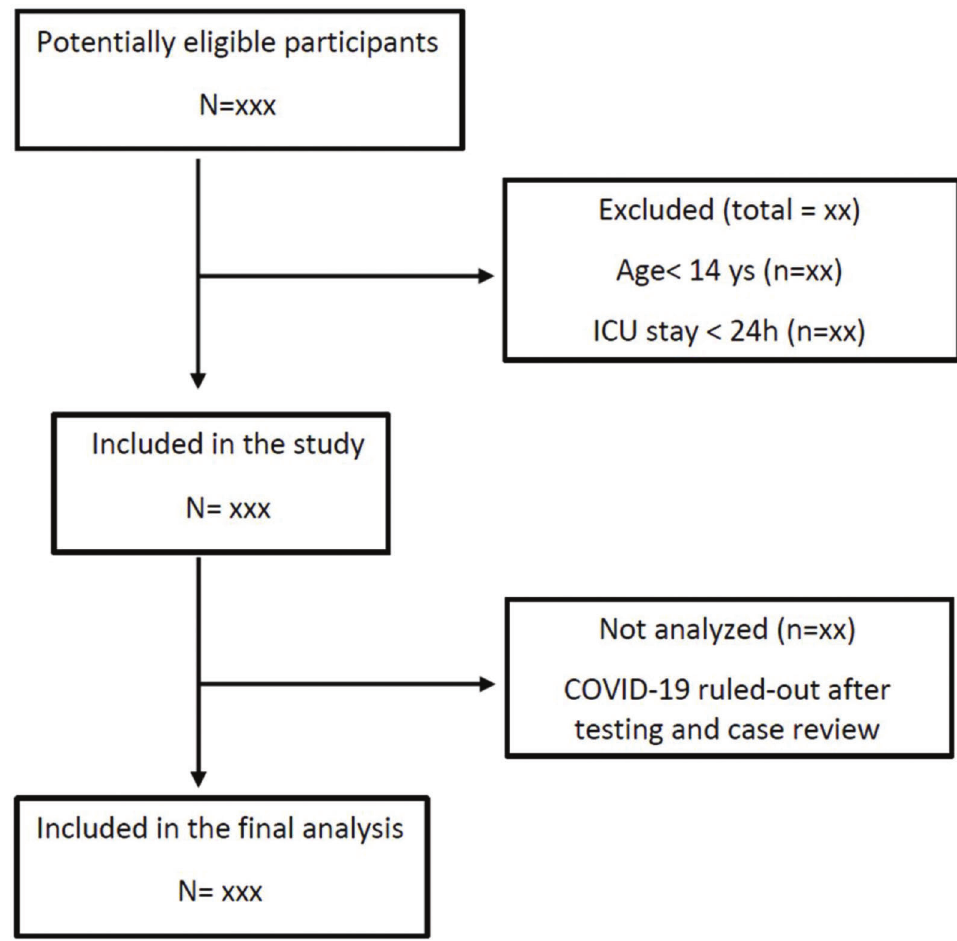
Figure 1 - Expected flow of potentially eligible participants in the